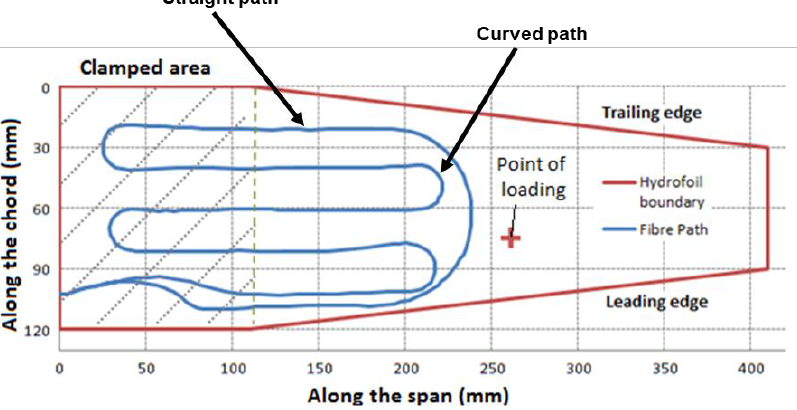
Figure 1. Layout of the distributed fibre optic sensor (DFOS) in straight path and semicircular path for measuring strains on a composite structure [12].